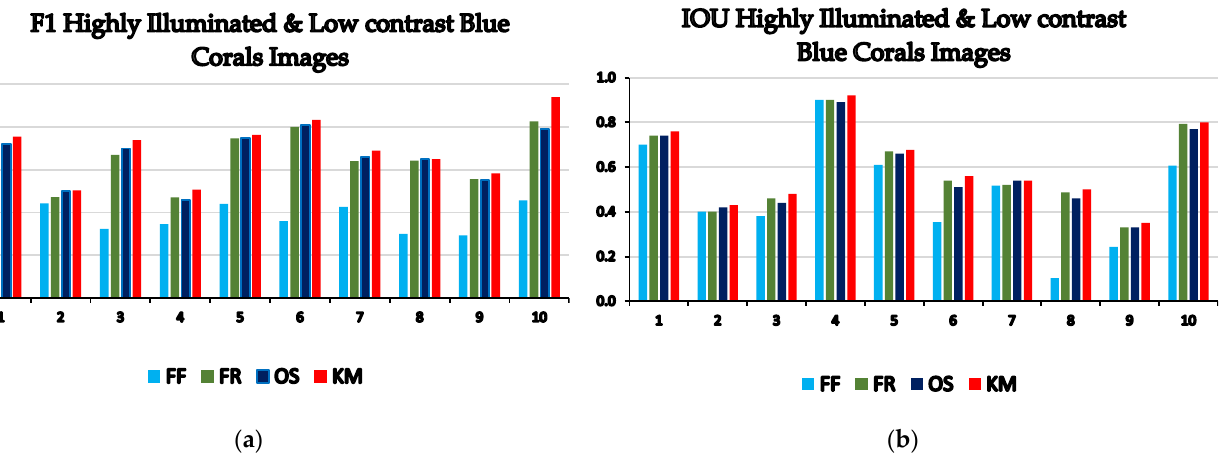
Figure 15. The results of evaluating the tested segmentation algorithms using highly illuminated and low contrast blue coral images. Images (1 – 5) had two categories, and (6 – 10) had three categories: ( a ) F1-score; ( b ) IOU.